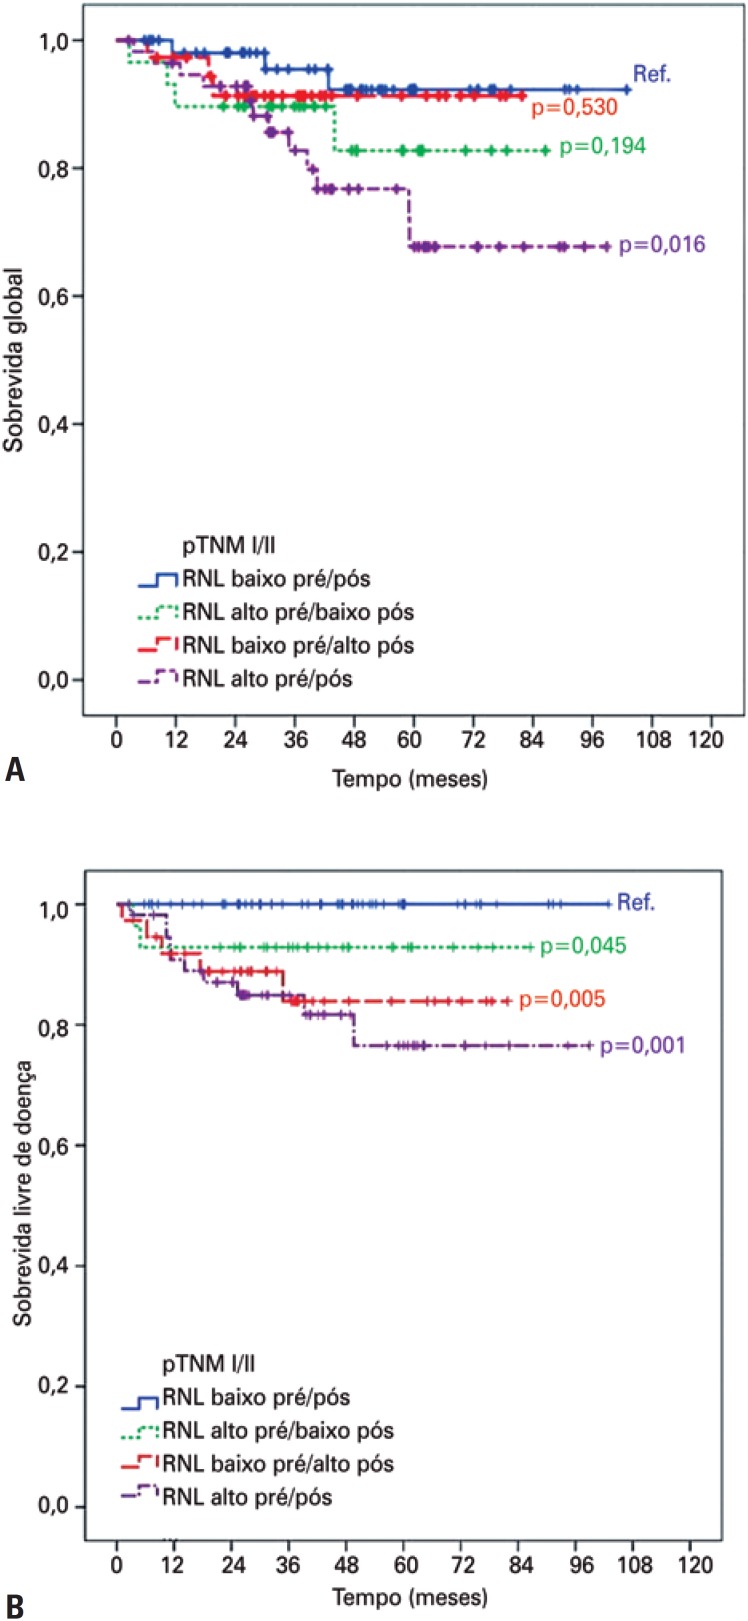
Curva de Kaplan-Meier comparando sobrevida global (A) e sobrevida livre de doença (B), de acordo com o subgrupo da relação linfócito-neutrófilo para estágios I/IIRLN: relação linfócito-neutrófilo.